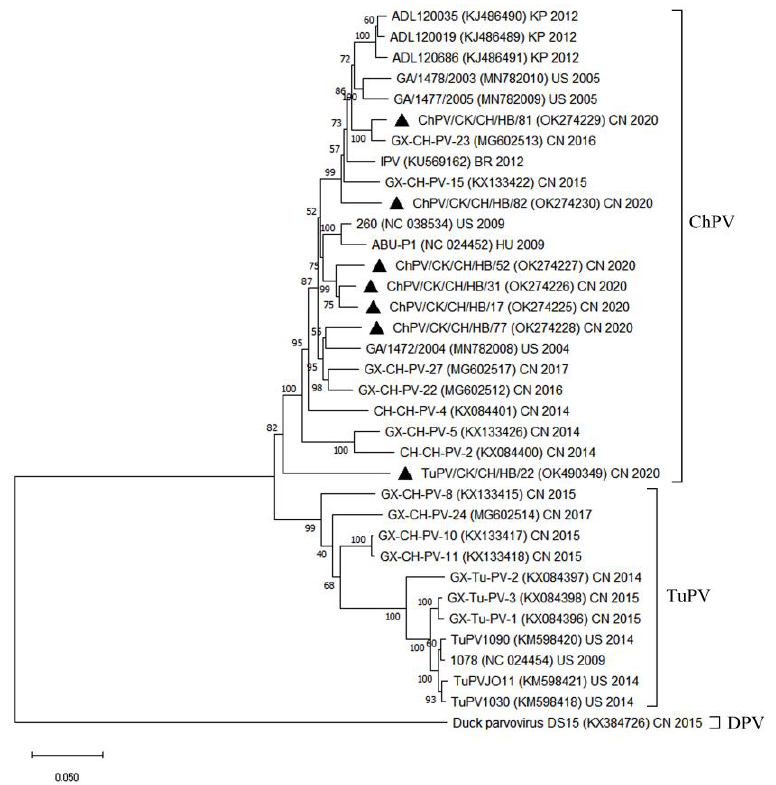
Figure 1. Phylogenetic tree based on the complete sequence gene of parvovirus. Molecular Evolu- tionary Genetics Analysis version 11 was used to perform the phylogenetic tree reconstruction, using the neighbor-joining algorithm with 1000 bootstrap replicates. The tree was drawn to scale, with branch lengths in the same units as those of the evolutionary distances used to infer the phylogenetic tree. Accession numbers are shown in parentheses. Strains with ▲ represent PV sequenced in this paper. The sequence of duck parvovirus was used as the out-group control. CN, China; US, United States; HU, Hungary; BR, Brazil; KR, South Korea.